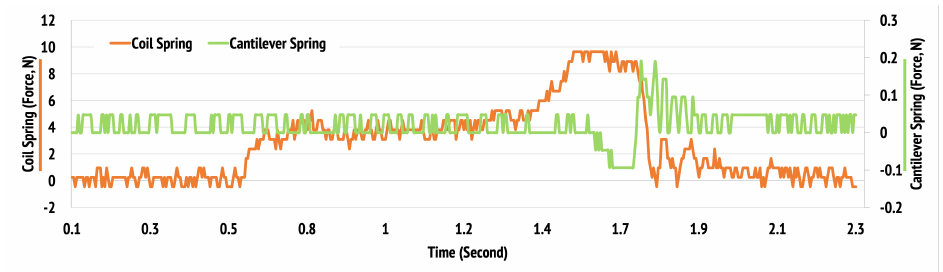
Figure 15. The results of force estimation from the data collected Shooter’s Touch system. Left Y-axis is the force of coil spring. Right Y-axis is the force of cantilever